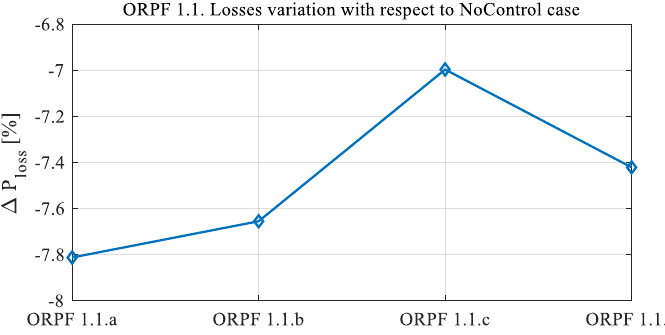
Figure 22. ORPF 1.1 results: power losses variation with respect to initial case.